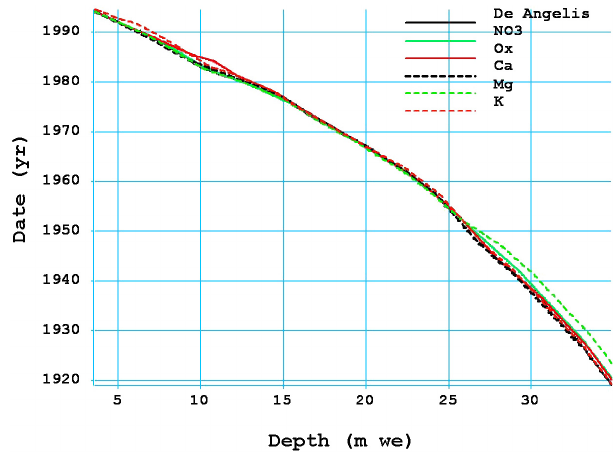
Figure 13. Comparison of chronologies deduced from nitrate (NO 3 ), oxalate (Ox), calcium (Ca), magnesium (Mg), and potas- sium (K) concentration profiles with the chronology established by de Angelis et al.